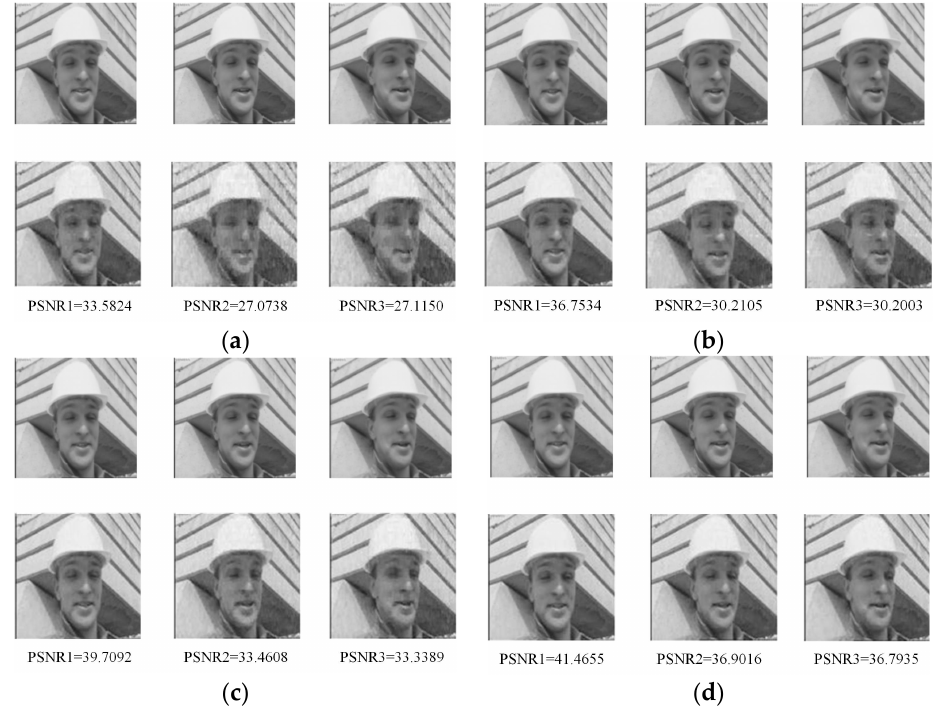
Figure 10. Comparison of the first three frames of “foreman” at different AMR: ( a ) AMR = 0.4667; ( b ) AMR = 0.5667; ( c ) AMR = 0.6667; and ( d ) AMR = 0.7667.